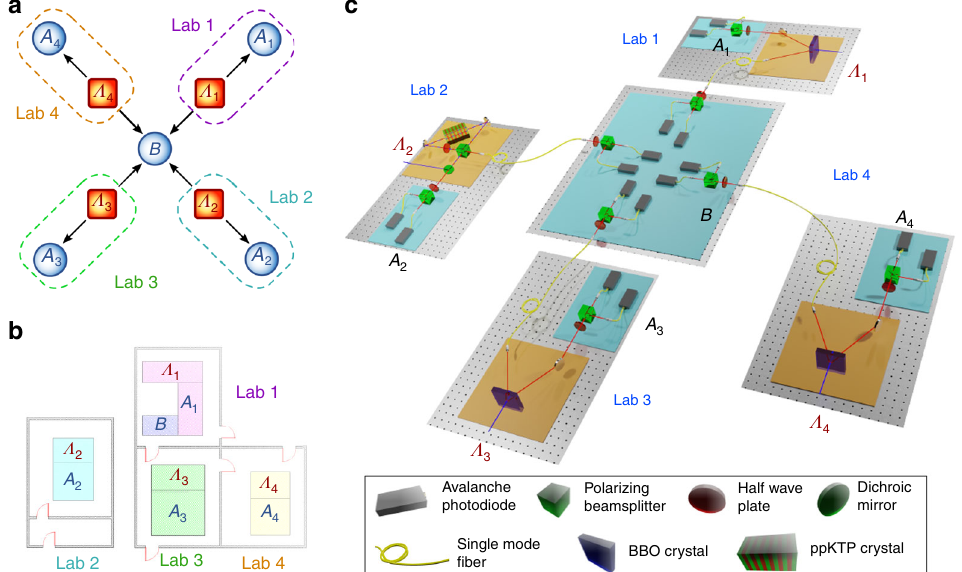
Fig. 2 Experimental apparatus. a Four independent polarization-entangled photon pair sources and fi ve measurement stations are available for the experimental realization of violation of the chained n -locality inequality (7) in a star-network con fi guration. b Physical location of the laboratories and scheme of the experimental apparatus. Distinct laboratories contain one source and one measurement station each, with the exception of Lab. 1, which also contains the central node B of the star-network on a separate optical table. c The entangled photon sources Λ 1 , Λ 3 , and Λ 4 are realized using a Beta-Barium Borate (BBO) crystal, pumped in a pulsed regime, which emits photon pairs at 785 nm using spontaneous parametric down-conversion (SPDC) of type II. The source Λ 2 instead is pumped in continuous-wave regime and employs a periodically poled KTP crystal placed inside a Sagnac interferometer to generate entangled photon pairs at 808 nm via a type II SPDC process. Single photons are then measured in polarization using a half-wave plate (HWP) followed by a polarizing beam splitter